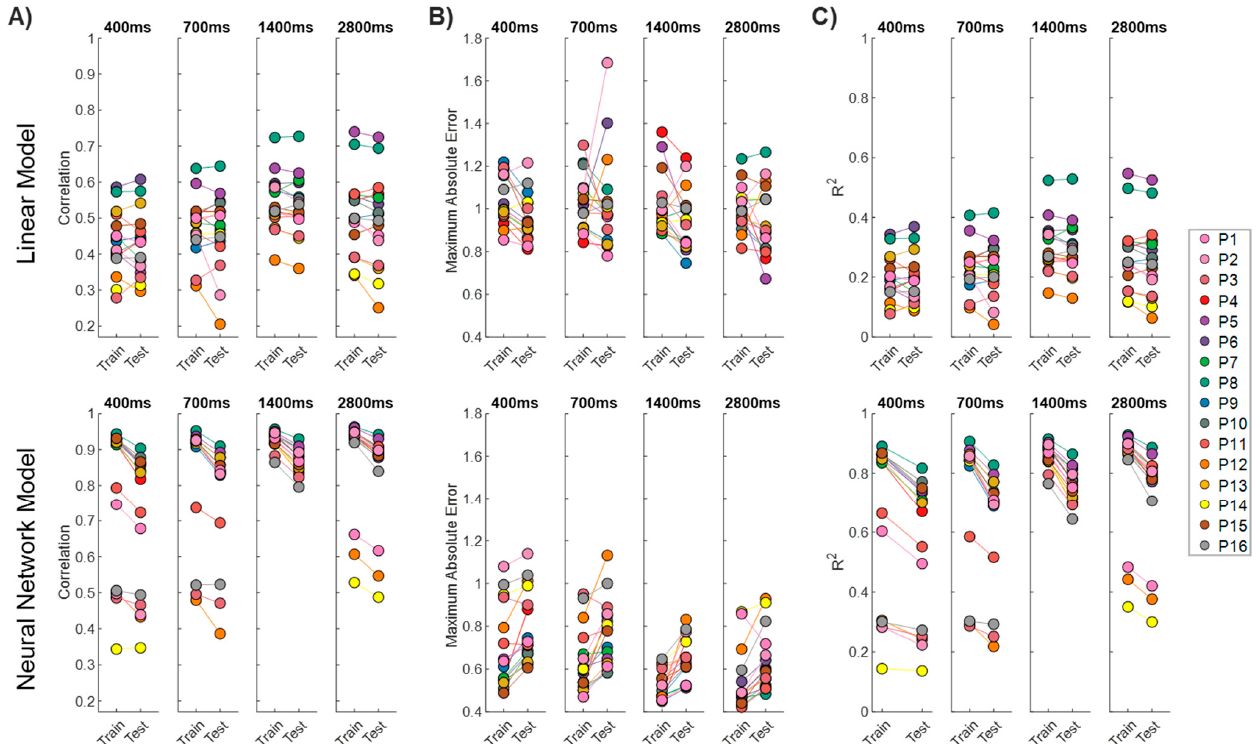
Figure 5. For the four epochs, the ( A ) Pearson correlation coefficients, ( B ) maximum absolute error, and ( C ) 𝑅 2 for the training and testing sets for both the linear and neural network models.